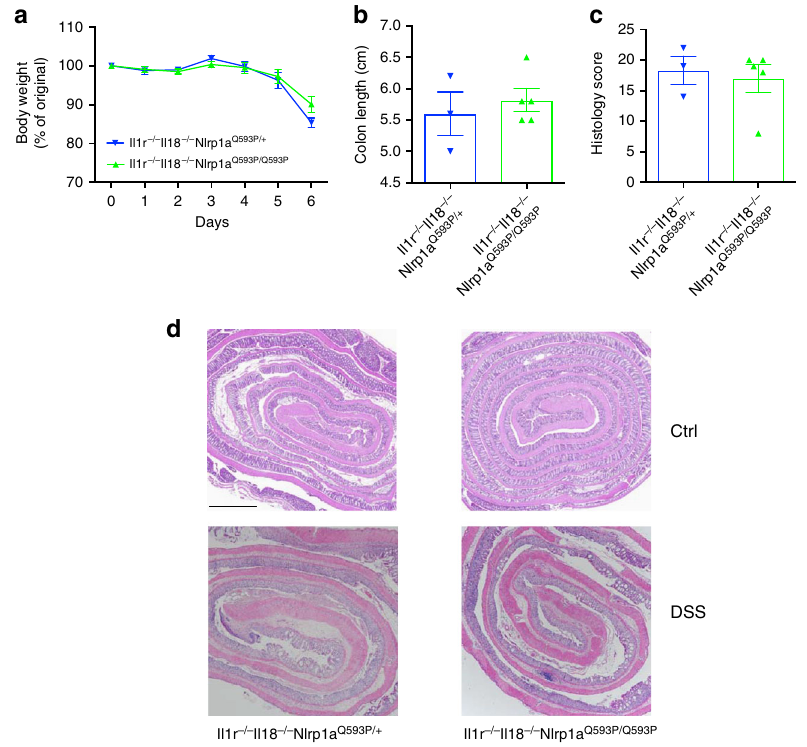
Fig. 5 Deletion of IL-18 removes the hyper-activated Nlrp1 DSS-induced colitis phenotype. Il-1r − / − Il-18 − / − Nlrp1a Q593P/ + and Il-1r − / − Il-18 − / − Nlrp1a Q593P/ Q593P mice were given 3% (w/v) DSS for 6 days. a The percentage weight loss, b colon length and c histology score for epithelial damage and in fl ammatory cell in fi ltrate of H&E-stained sections from the colon were measured for disease severity. d Representative H&E-stained sections of the distal colon from Il- 1r − / − Il-18 − / − Nlrp1a Q593P/ + and Il-1r − / − Il-18 − / − Nlrp1a Q593P/Q593P mice, scale bar = 1 mm. Data are representative of 2 independent experiments with 3 – 5 mice per group. Means ±